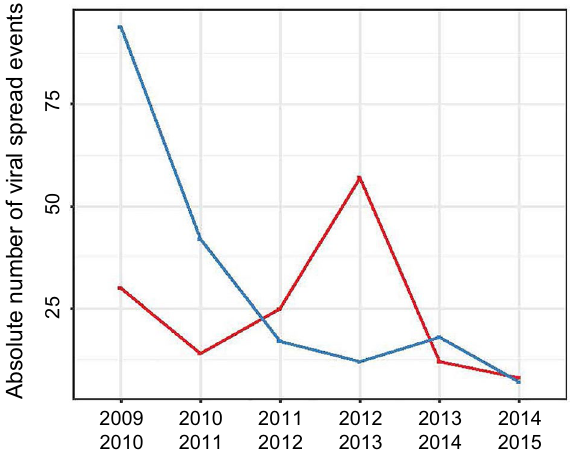
Figure 4. Opposed alternation of influenza A virus viral spread events. Total number of viral spread events between different geographical locations of influenza A/H1N1 (blue, n = 190) and A/H3N2 (red, n = 146) viruses were pooled by 1-year intervals from the start of the 2009 pandemic. Viral spread counts were performed by traversing the fully-spatiotemporal-resolved phylogenetic trees in